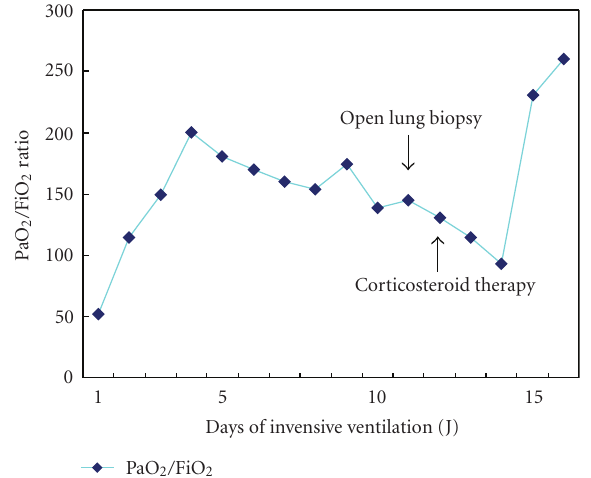
Figure 3: PaO 2 /FiO 2 ratio during invasive ventilation.